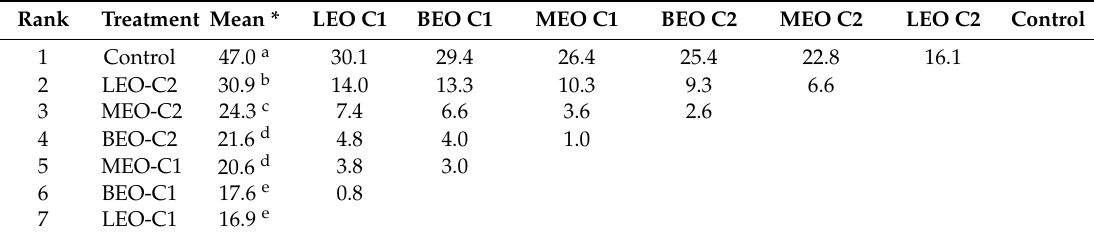
* mean ( n = 8) with di ff erent superscript letters indicating that the di ff erences are statistically significant for α = 0.05; C1—concentration corresponding to IC50, C2—half of C1 according to Table 1 (MEO-C1 = 183 µ L · L − 1 , BEO-C1 = 46 µ L · L − 1 , LEO-C1 = 86 µ L · L − 1 , MEO–C2 = 91.5 µ L · L − 1 , BEO-C2 = 23.0 µ L · L − 1 , LEO-C2 = 43.0 µ L · L − 1